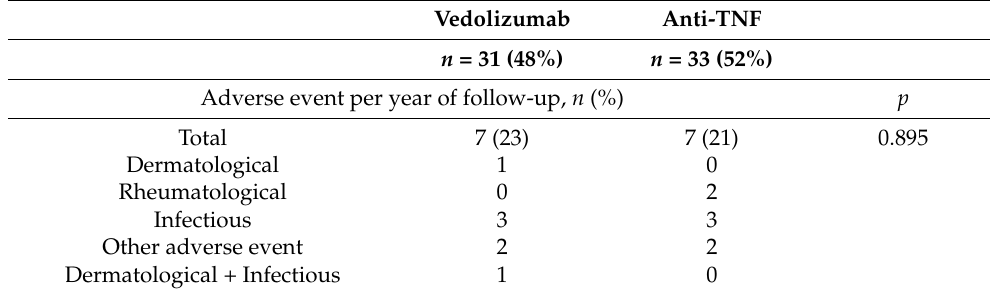
Table 5. Comparative safety of vedolizumab and anti-TNF in patients with ulcerative